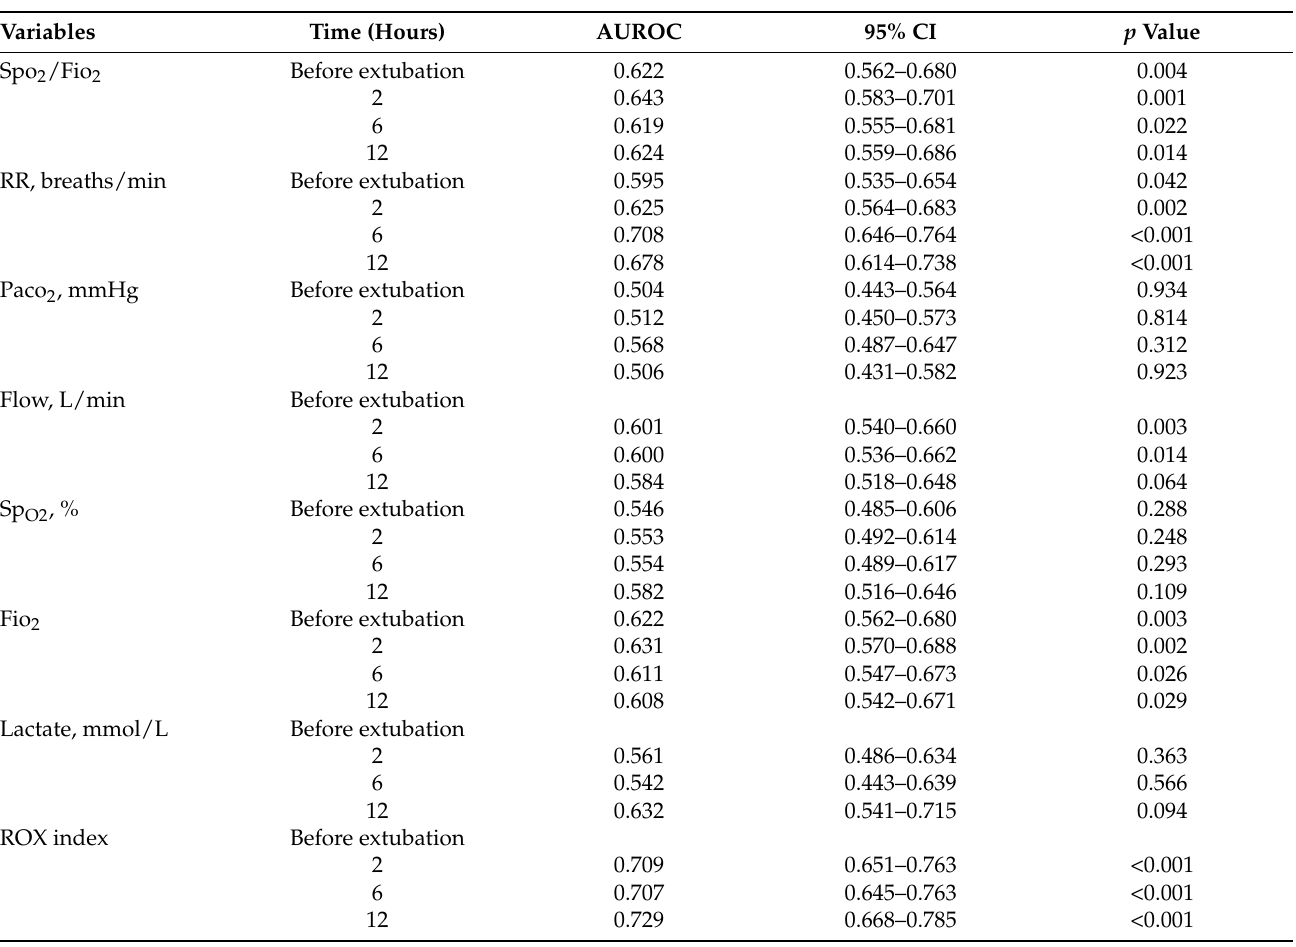
Table 2. Diagnostic accuracies of different respiratory variables at different time points for predicting the success of high-flow nasal cannula therapy within 72